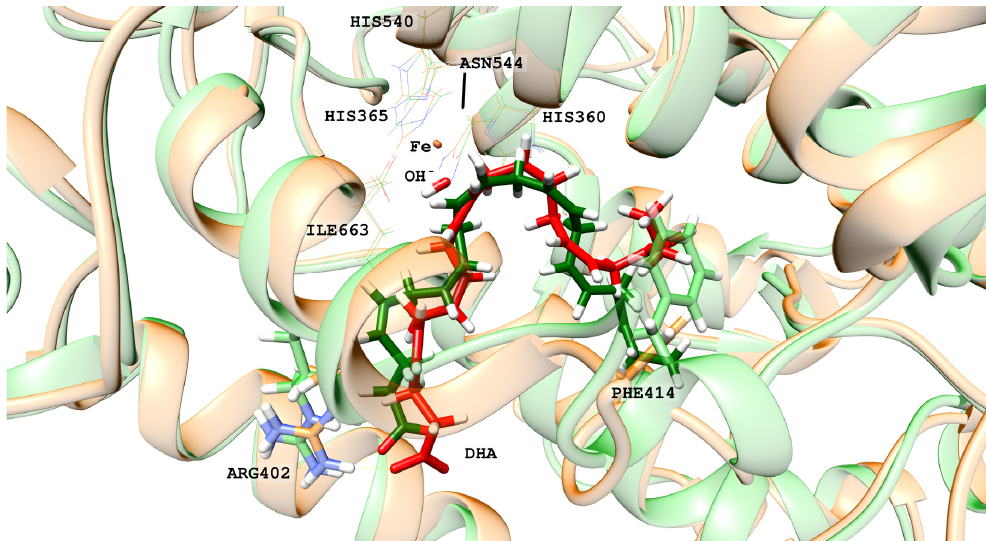
Figure 3. DHA binding mode in the closed (in green) and the open (in red) conformations of hALOX12. The interaction between Arg402 and the carboxylate group of DHA is shown as well as the rotation of Phe414.